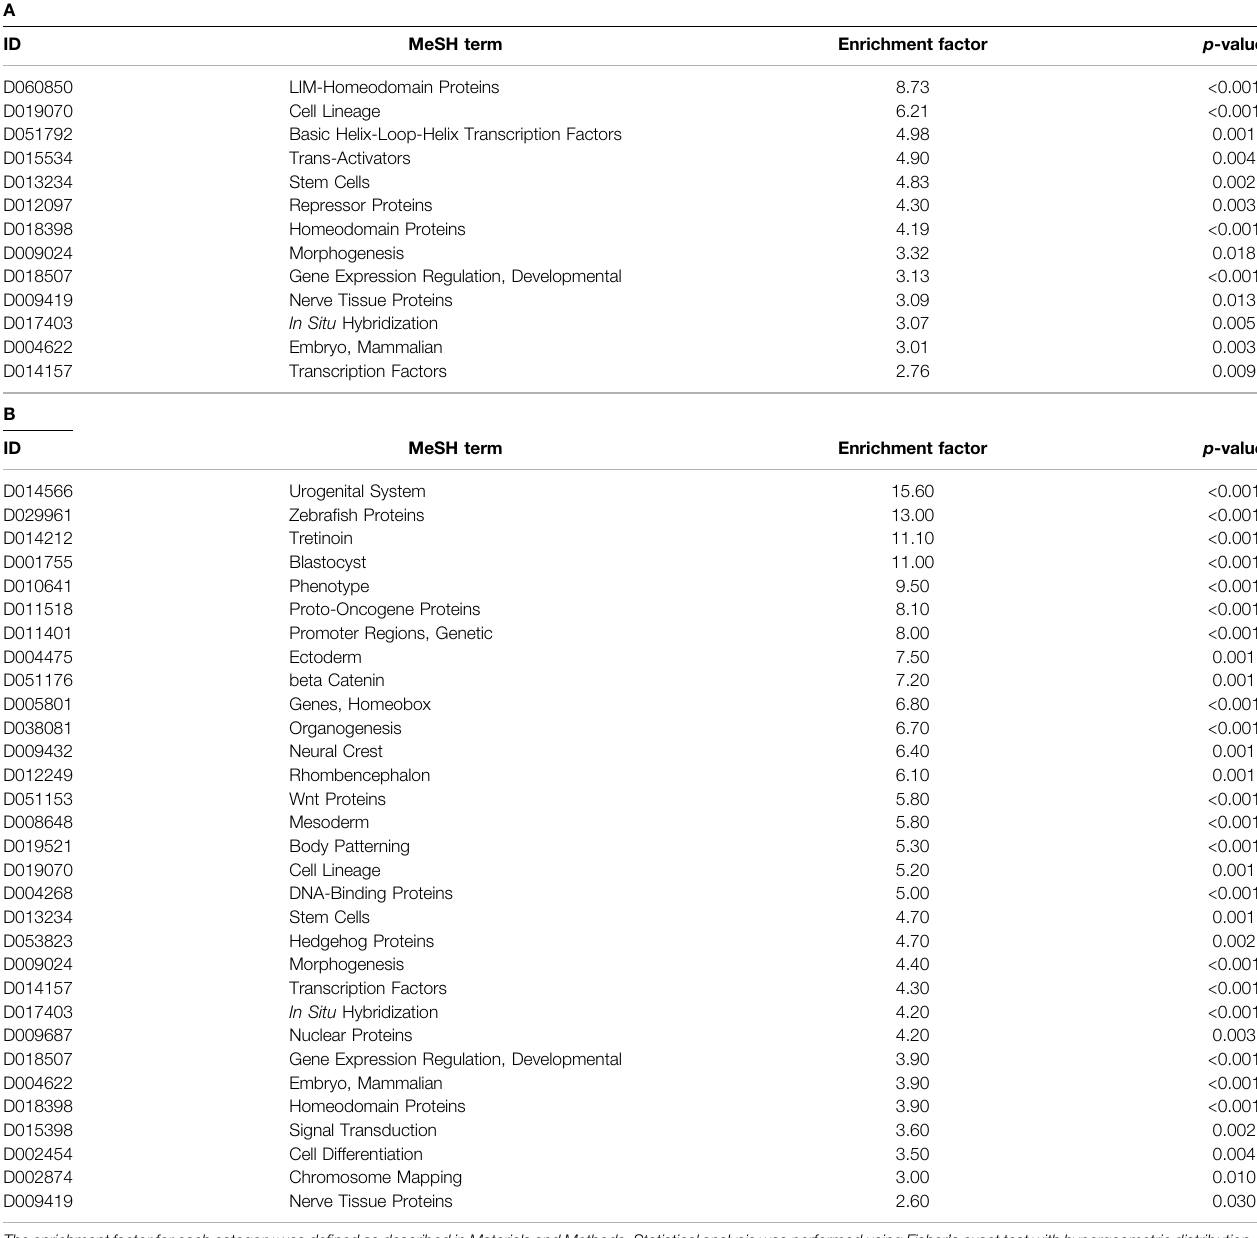
TABLE 4 | MeSH terms enriched in the genes that showed differential expression accompanied by altered DNA methylation in male (A) and female (B) offspring in the TiO 2 -H